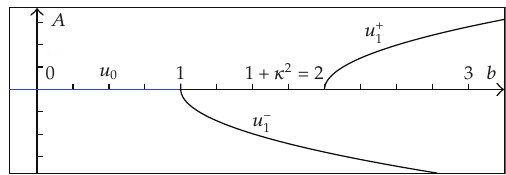
Figure 1: The bifurcation picture for κ (cid:6)